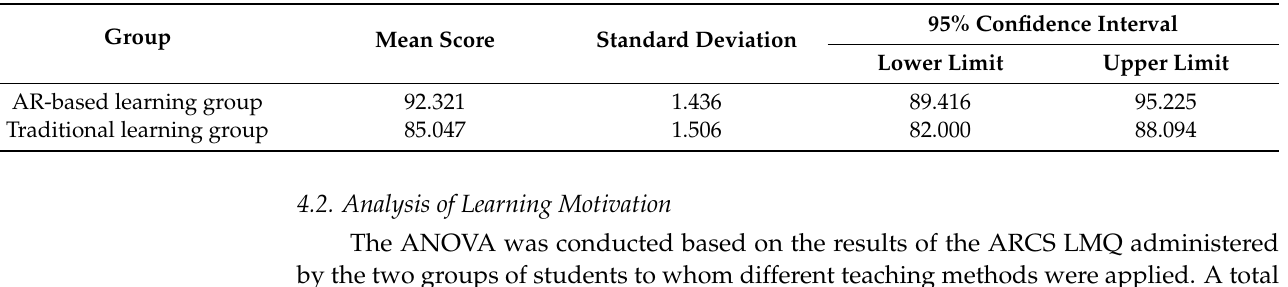
Table 7. Marginal mean.